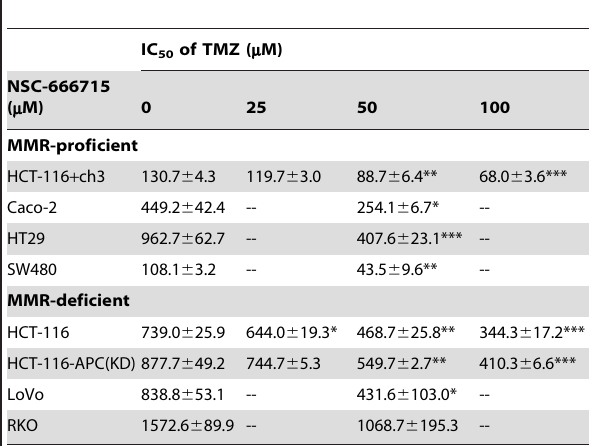
Table 1. Effect of NSC-124854 on TMZ-mediated cell growth inhibition of MMR-proficient and MMR-deficient colon cancer cell lines in culture.